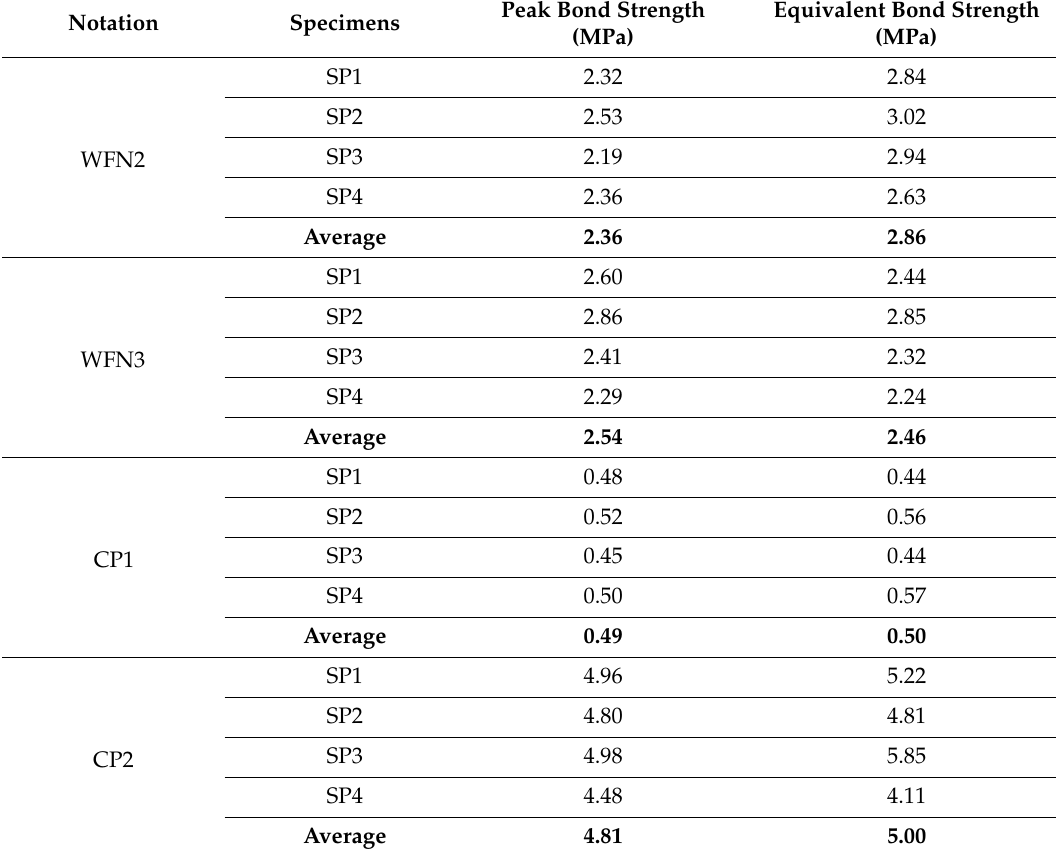
Table 5. Calculated bond strength.